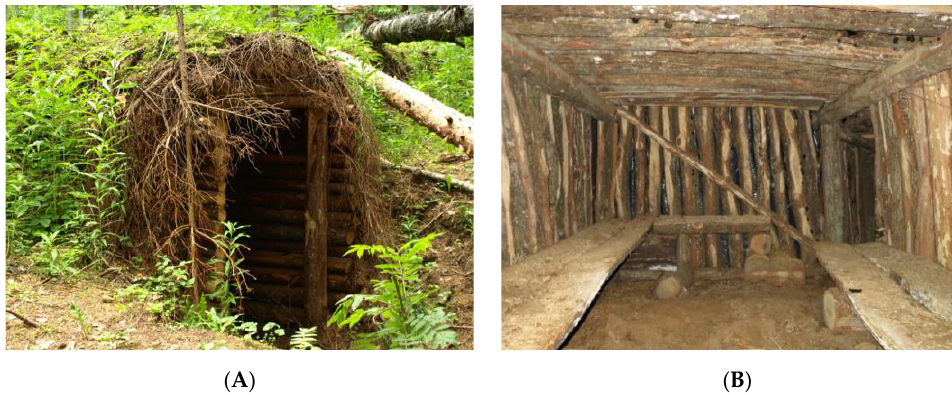
Figure 14. ( A ) Partisan dugout (Pašiliai Forest); ( B ) Partisan dugout (Žalioji Giria). Available online: